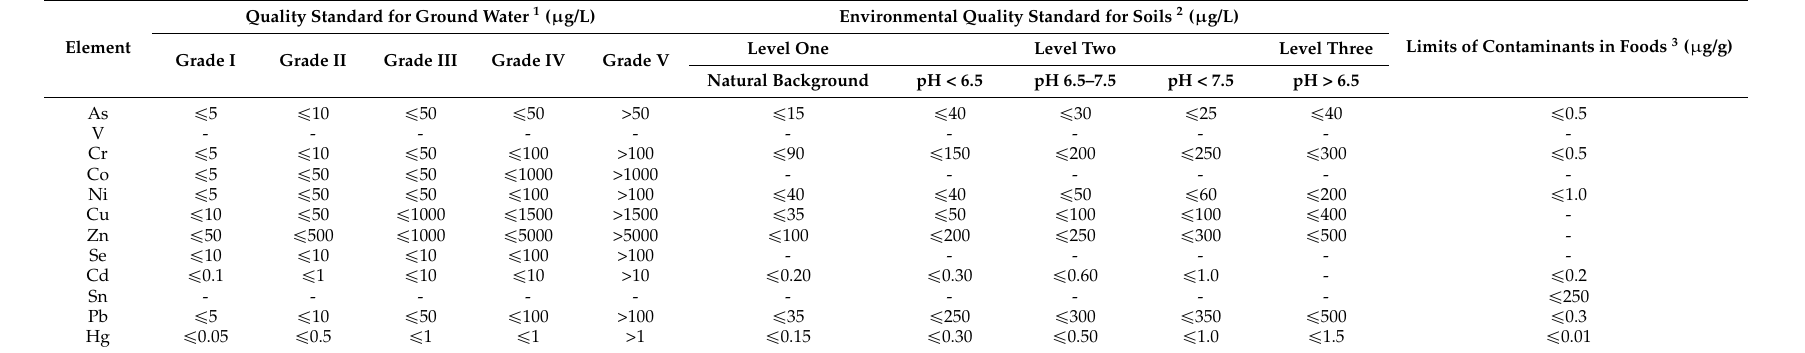
Table 10. Concentrations of trace elements defined in groundwater, soils and